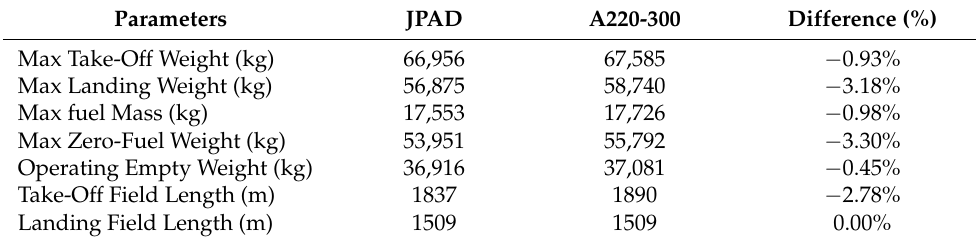
Table 3. Comparison between JPAD output and A220-330 data in Table